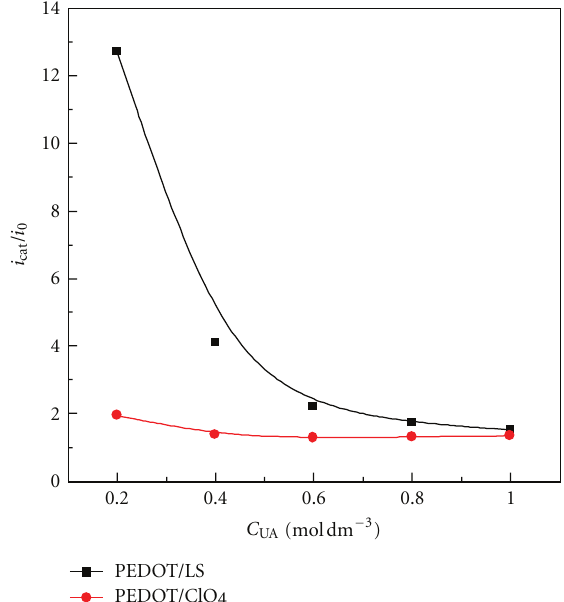
Figure 8: AA-induced peak current enhancement of UA on PEDOT/ClO 4 (red line) and PEDOT/LS film (black line) as a func- tion of UA